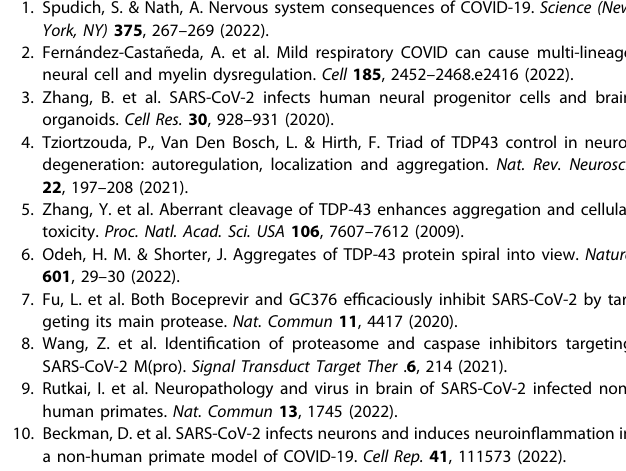
Fig. 1 The main SARS-CoV-2 protease Nsp5 cleaves the TDP-43 protein into a cytotoxic form in human neural cells. a Expression plasmids of SARS-CoV-2-encoded proteins were cotransfected with pVR1012-HA-TDP-43 into HEK293T cells. Forty-eight hours later, samples